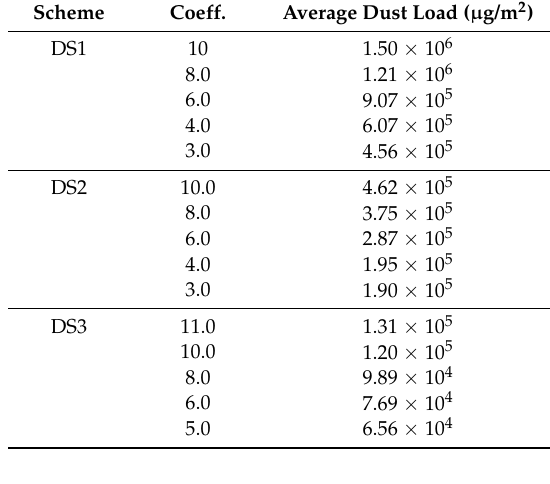
Table 9. Average dust load in ( µ g/m 2 ) over domain D2 for dust storm March 2013.